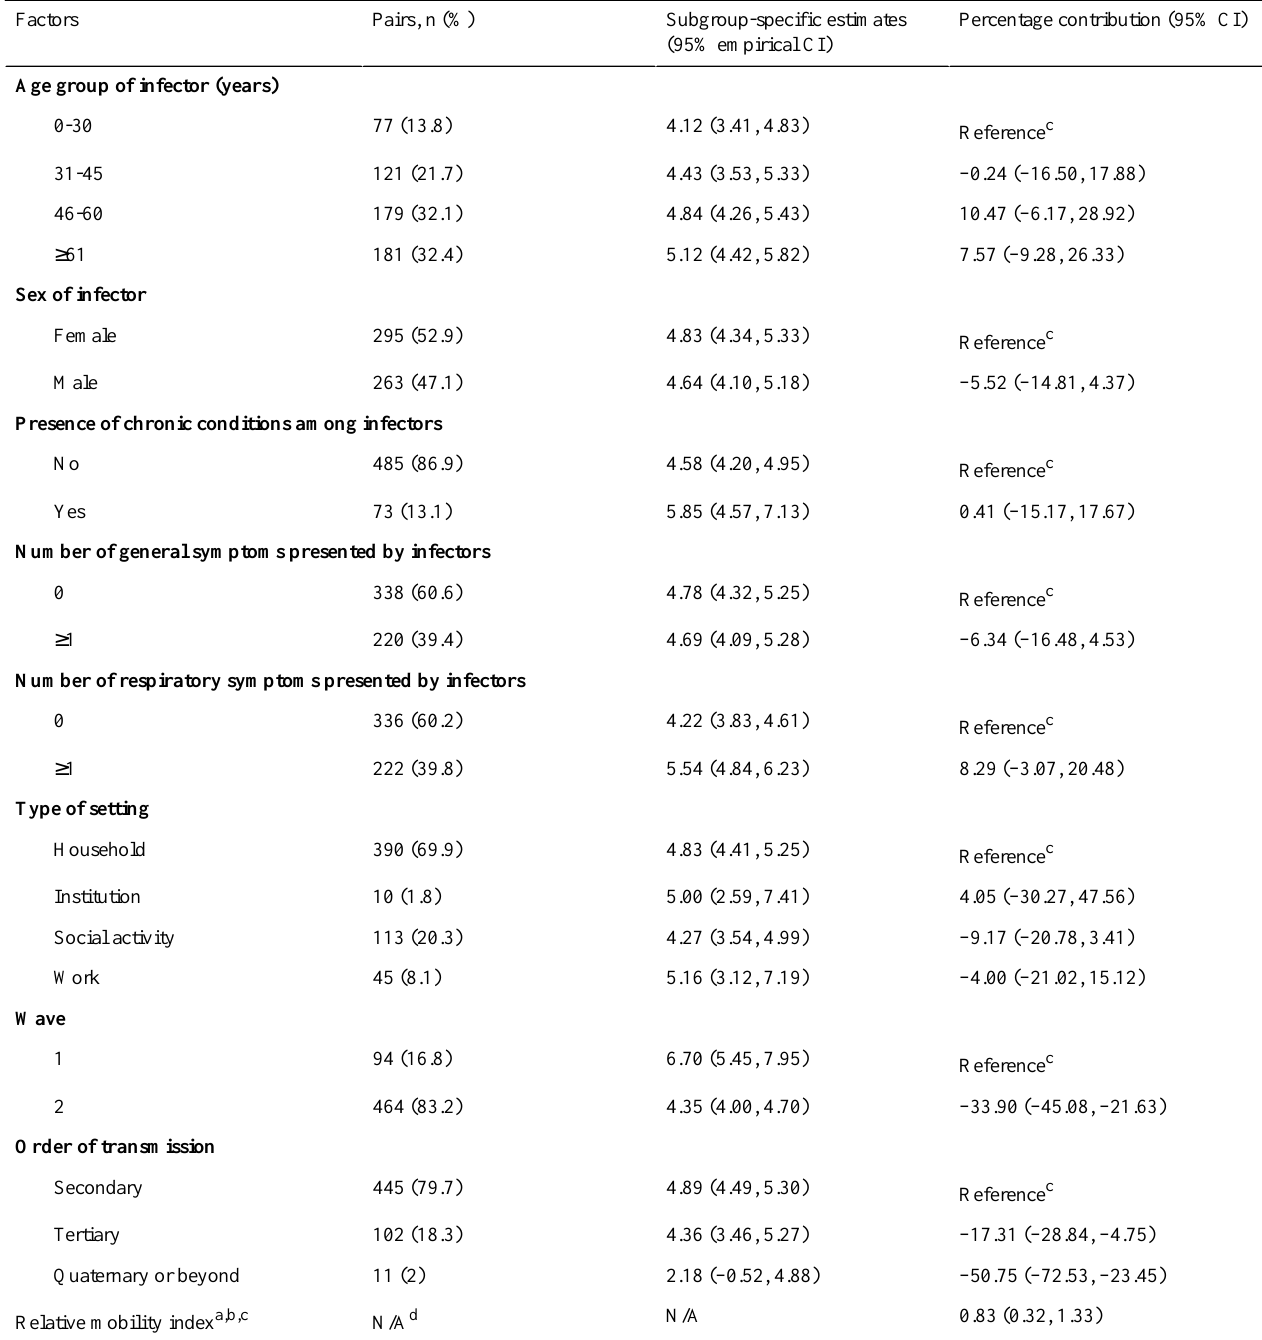
Table 4. Estimates of and factors associated with serial interval based on 558 infector-infectee pairs.